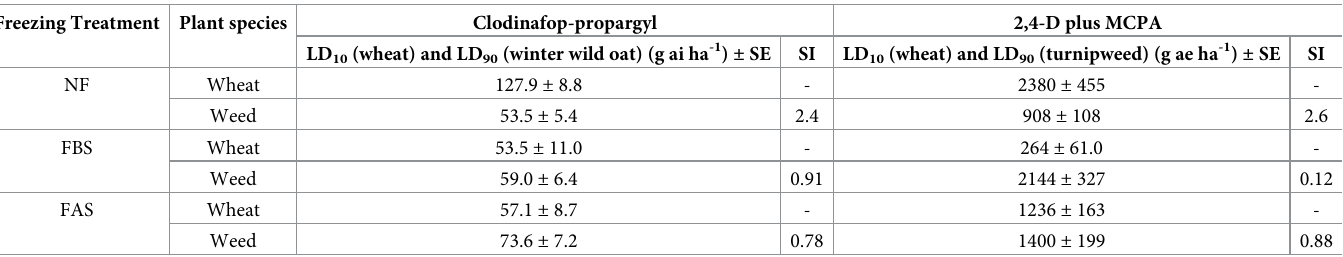
Table 2. Sensitivity of plant species of wheat, winter wild oat, and turnipweed to clodinafop-propargyl and 2,4-D plus MCPA under different freezing treatments. Freezing Treatment Plant